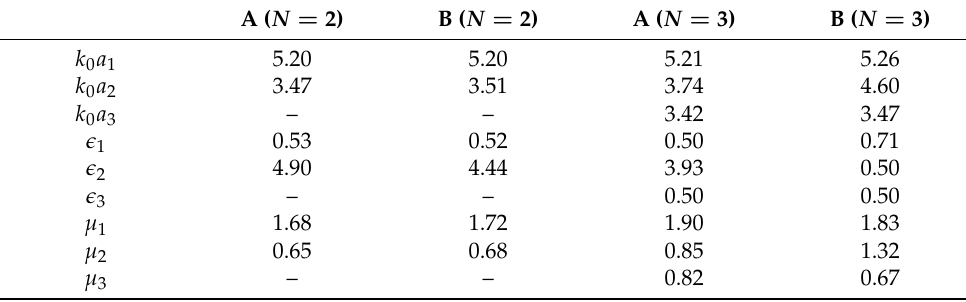
Table A7. Values of the optimization variables for optimized designs A and B of Figure